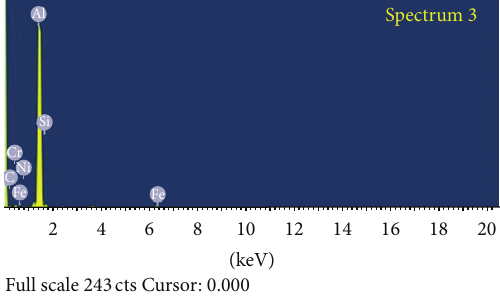
Figure 4: EDX spectrum of 6061 Al / SiC